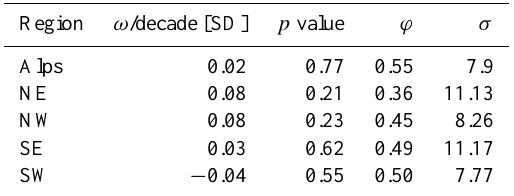
Table 3. Regression parameters trend ω per decade, p value, au- tocorrelation ϕ at lag-1 and standard deviation of the residuals σ for the SCA standardized anomaly time series illustrated in Figs. 11 and